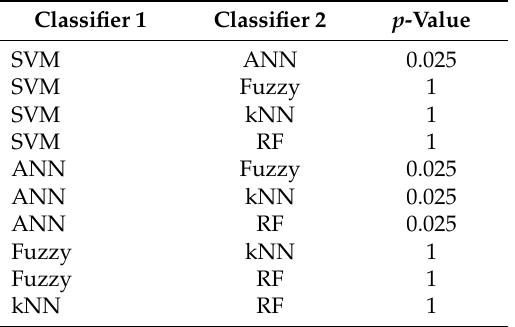
Table 7. Wilcoxon pair tests with corresponding p